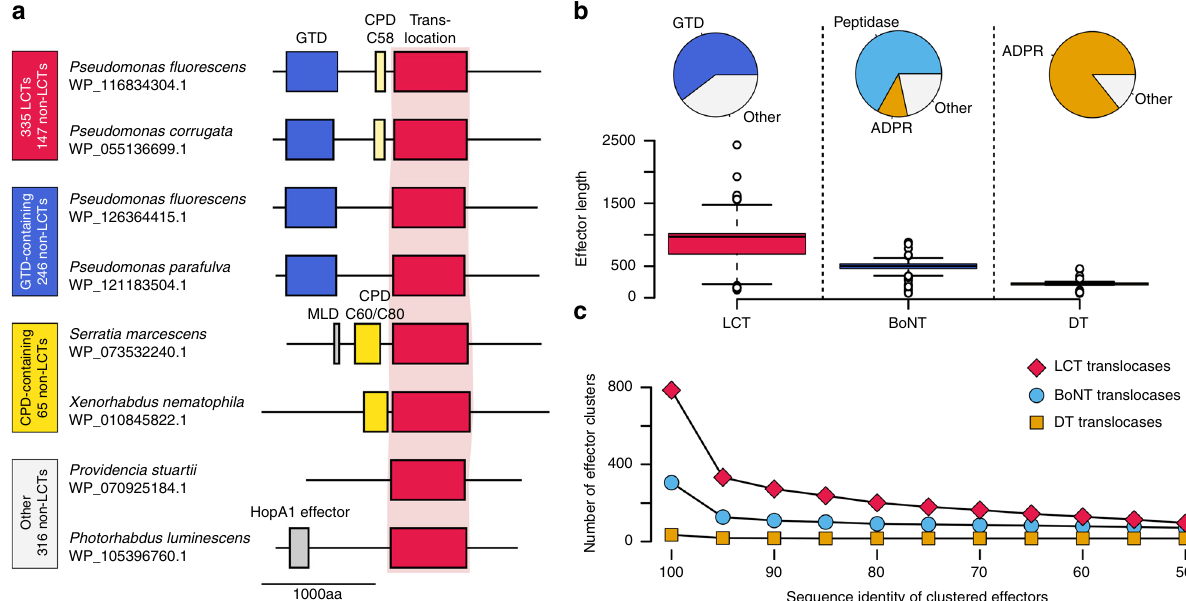
Fig. 2 Analysis of proteins with LCT-like T-domains. a Proteins with LCT-like T-domains can be found in three domain architecture types: LCT-like (red; 147 sequences), GTD-containing (blue; 246 sequences), CPD-containing (yellow; 65 sequences), and variable (other) composition (gray; 316 sequences). Within each domain architecture, two examples are shown. b By clustering the effectors at different levels of sequence identity, the diversity of effectors between the translocation domain families can be compared. At all levels of identity, the LCT family yields the largest number of effector sequence clusters, suggesting the LCT T-domain transports more diverse cargo than BoNT or DT translocases. c Comparison of effector lengths and types between BoNTs (blue), DTs (orange), and LCTs (red). The DT family possesses the smallest effectors, most of which are ADP-ribosyltransferases (ADPRs). The BoNT effector family is comprised mostly of metallopeptidases (peptidases) and ADPRs. The LCT family possesses the largest effectors, which are mostly